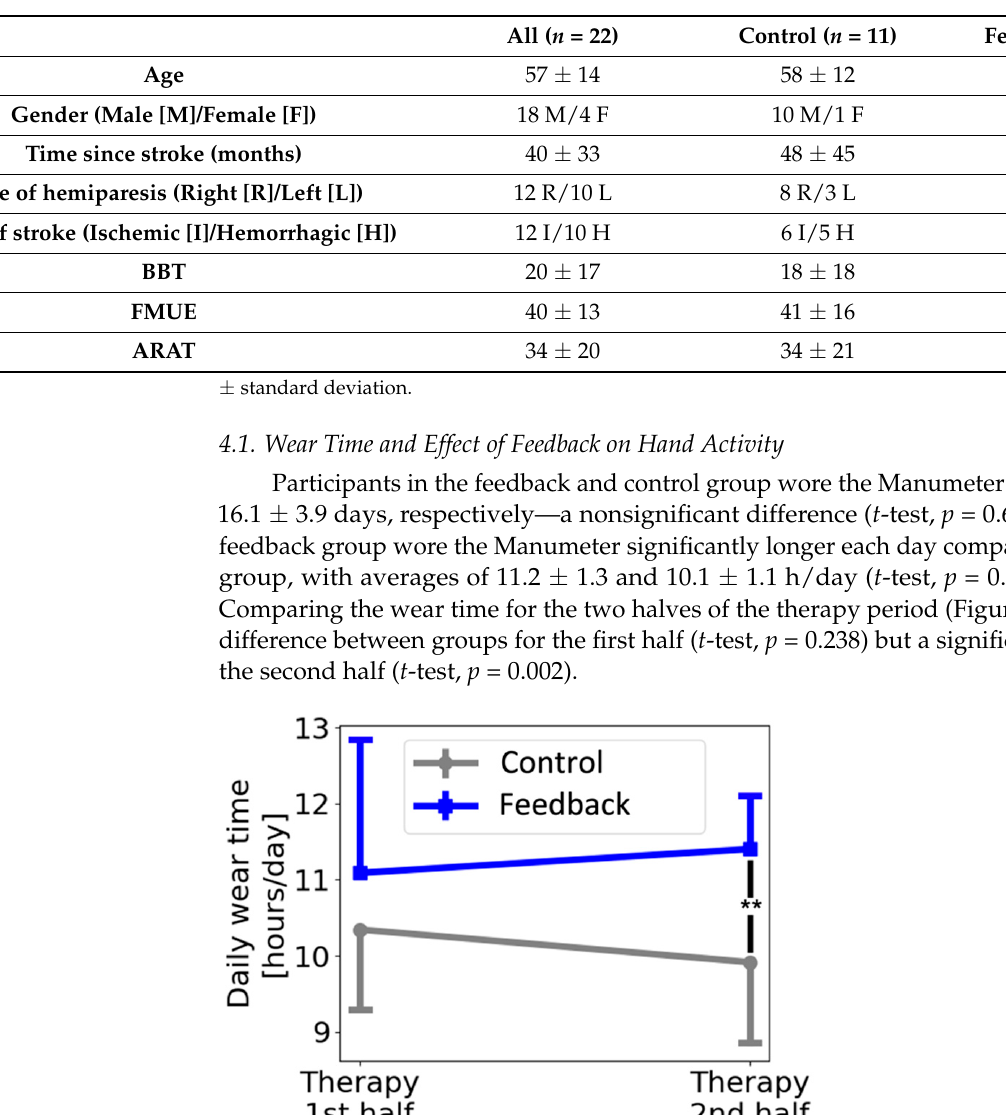
Table 1. Demographic data and key baseline clinical outcomes for RCT.